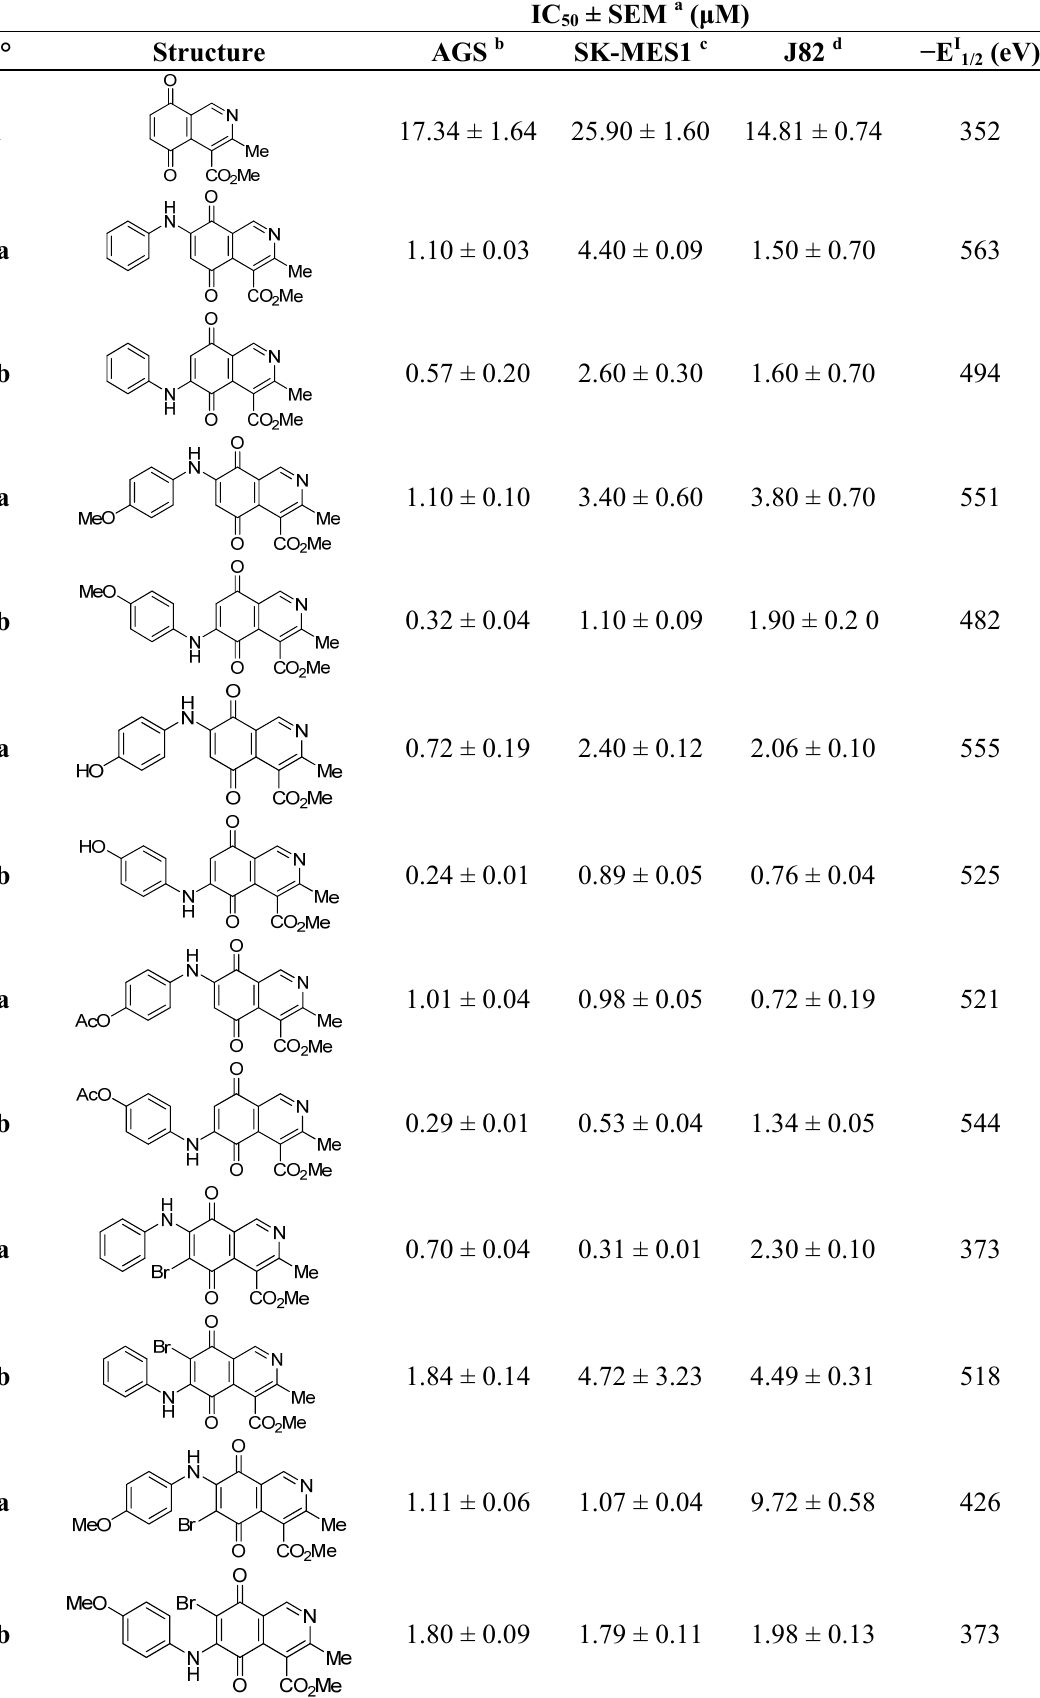
Table 3. Antiproliferative activity and half-wave potentials of 1 and their 6,7 - substituted